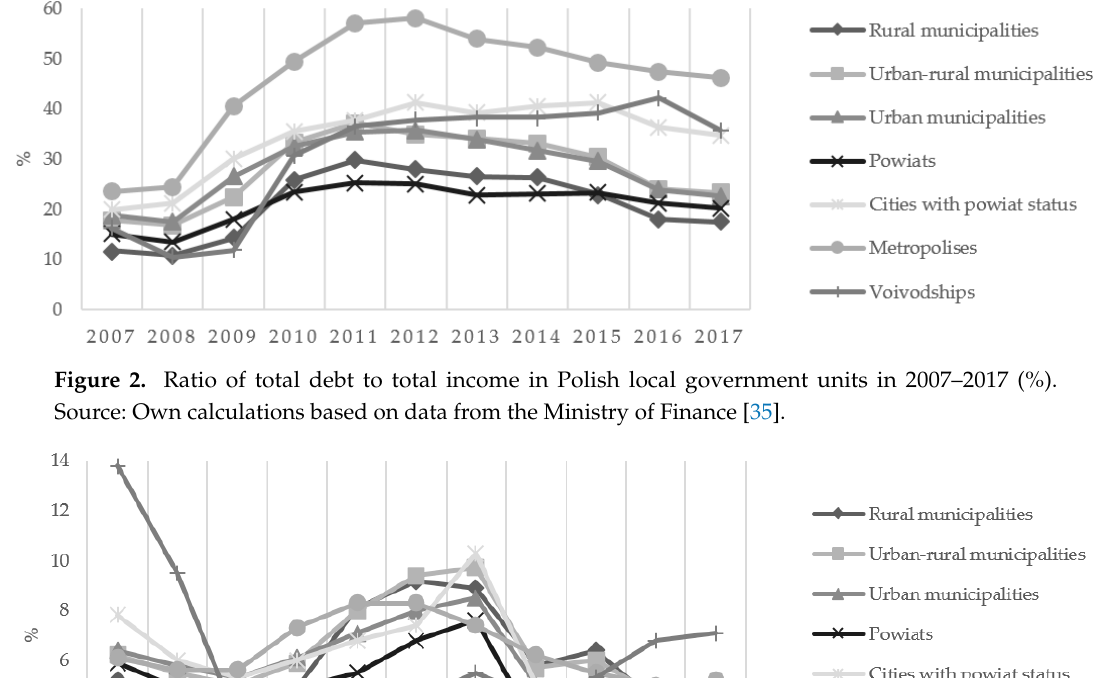
Figure 2. Ratio of total debt to total income in Polish local government units in 2007–2017 (%). Source: Own calculations based on data from the Ministry of Finance [35].